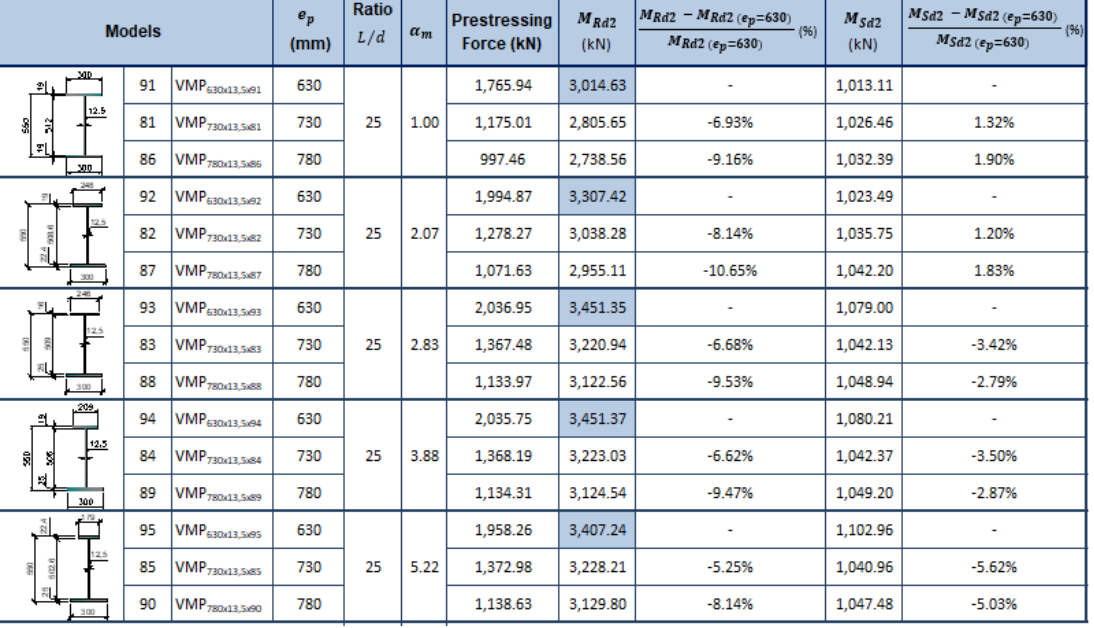
Figure 12. Eccentricity influence - / L d ratio =